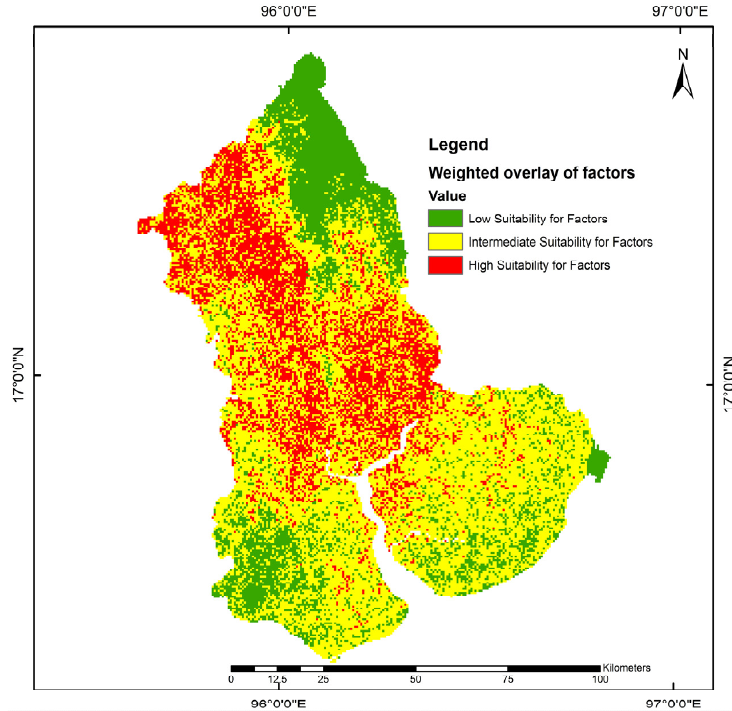
Figure 8. Factor variables for Weighted Overlay Map. Table 3. Evaluated Weight by AHP Method.